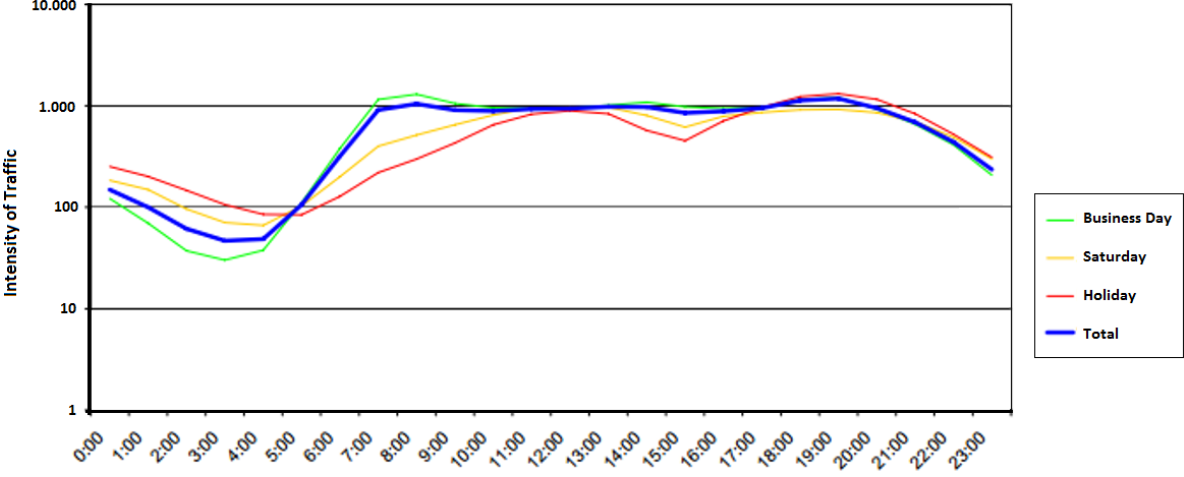
Figure 5. Number of vehicles per hour in a road from the Community of Murcia